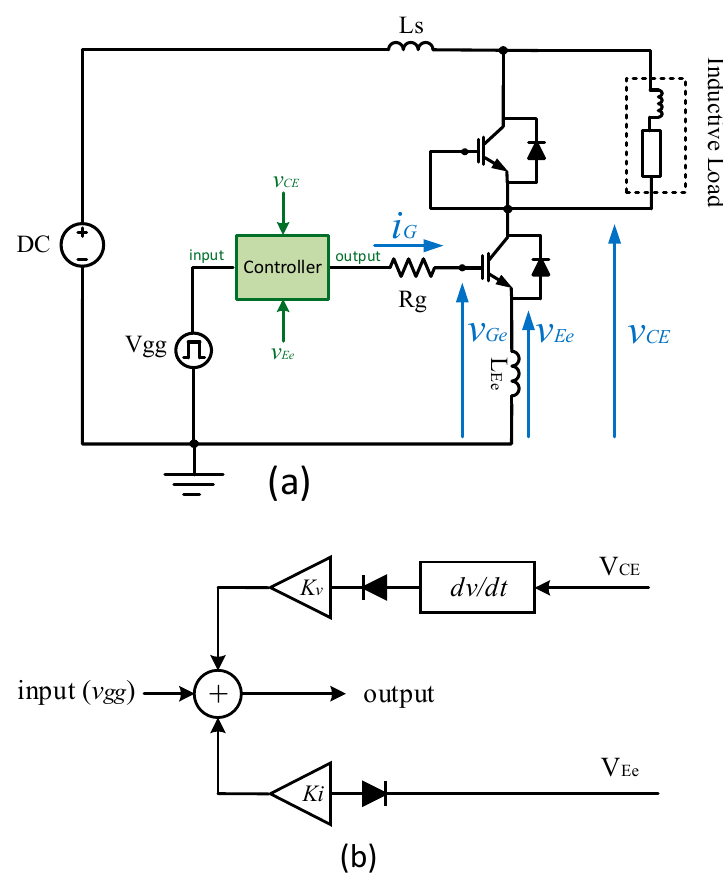
Figure 2. ( a ) The test circuit and the proposed controller in the gate driver (GD). ( b ) General scheme of the controller.